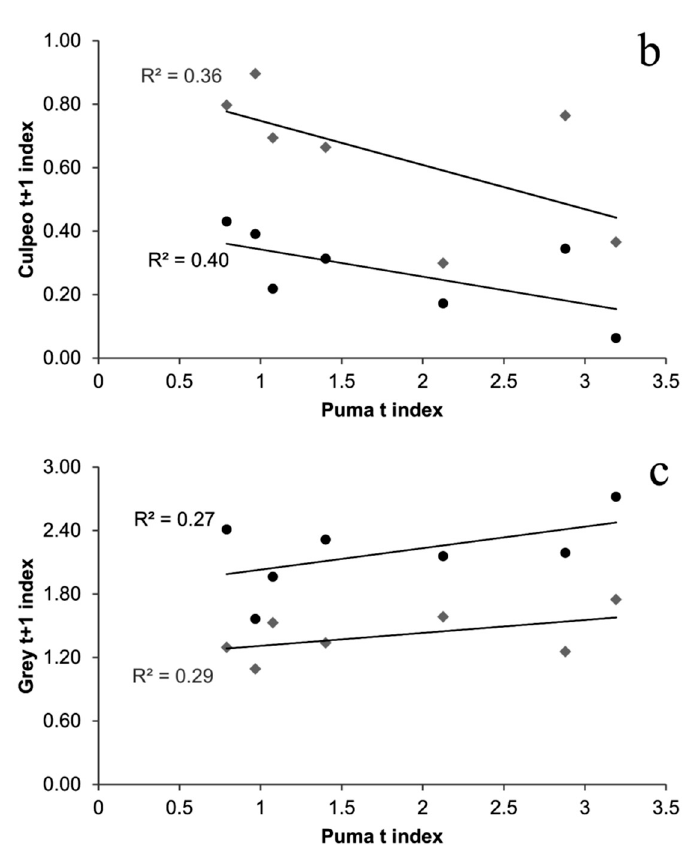
Figure 5. Relationships between culpeo fox and grey fox population trends ( a ) and puma and both fox species’ population trends ( b , c ) for autumn (black dots) and spring (grey diamonds). Goodness of fit for each season model is represented by the coefficient of determination (R 2 ).